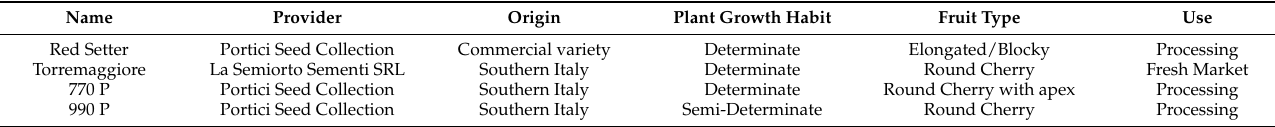
Table 2. Genotypes tested during drought stress